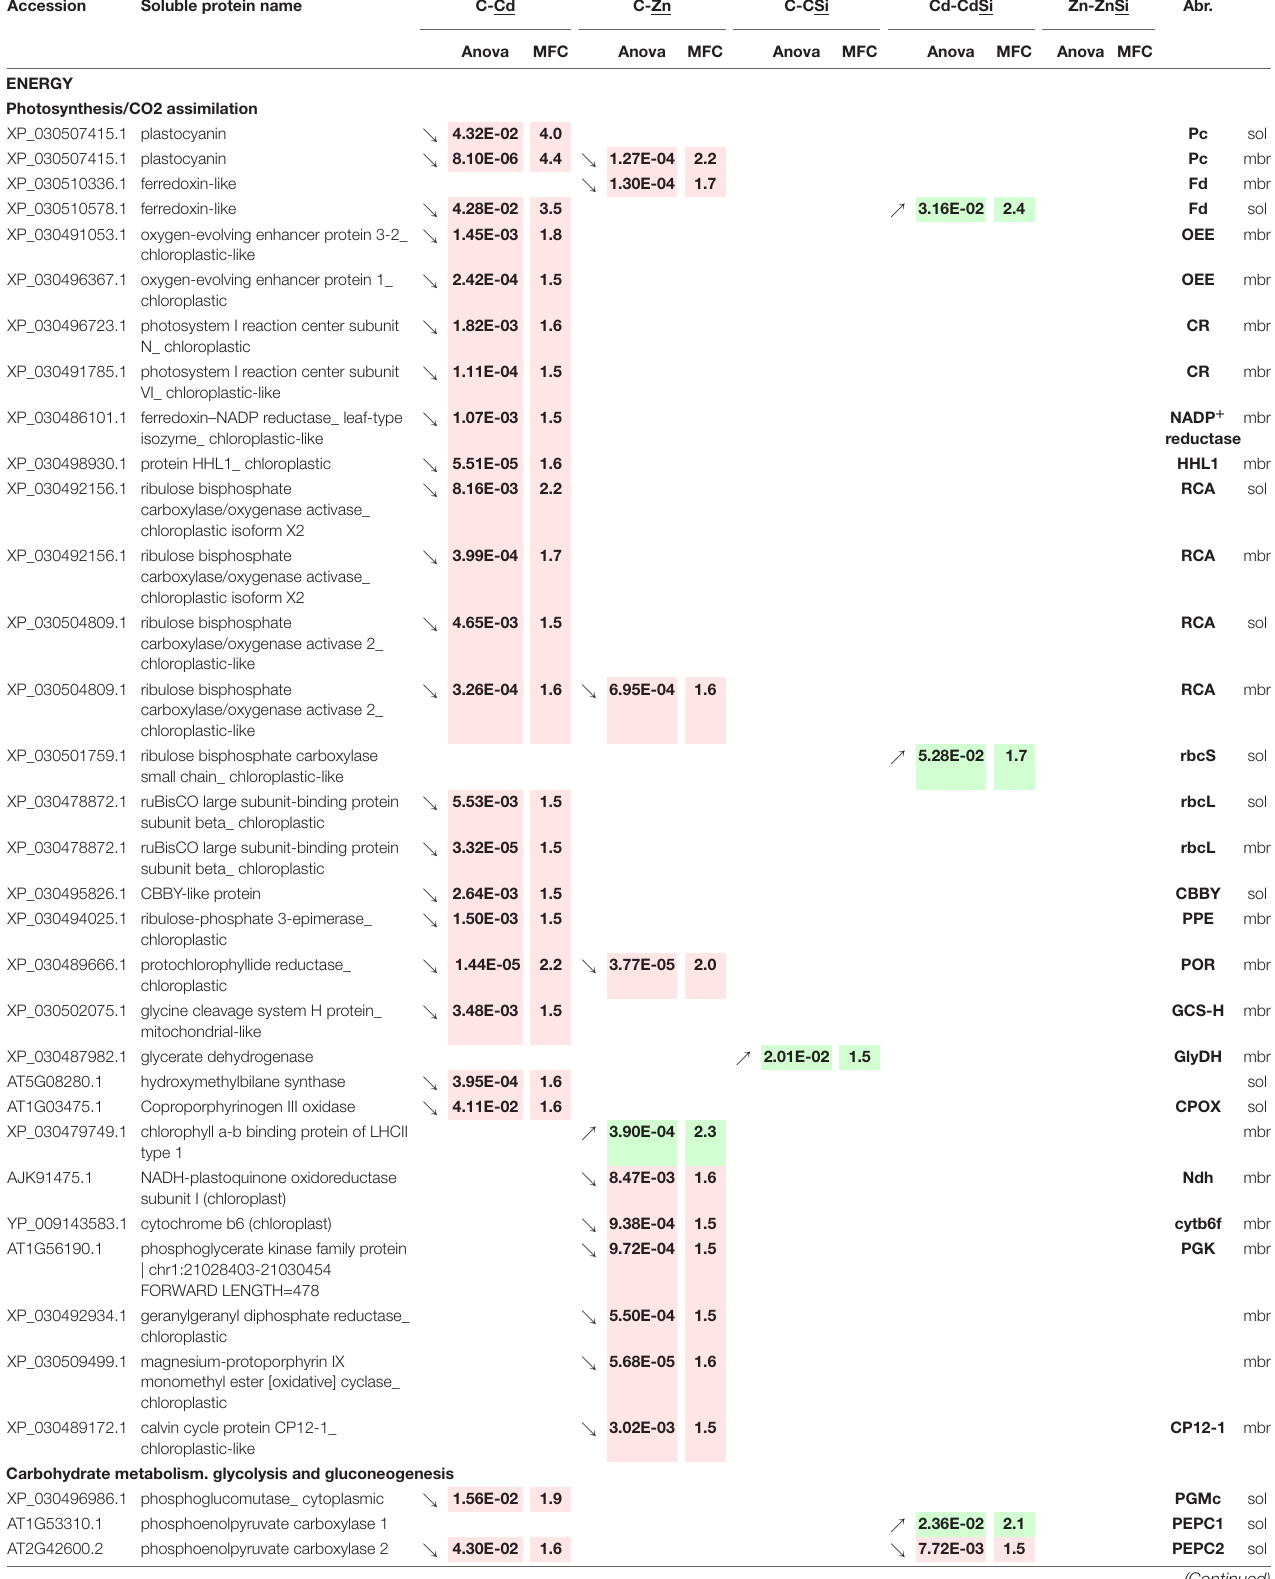
TABLE 1 | List of proteins with significant quantitative changes of hemp leaves in response to Cd. Zn and Si. Accession Soluble protein name C-Cd C-Zn C-CSi Cd-CdSi Zn-ZnSi Abr. Anova MFC Anova MFC Anova MFC Anova MFC Anova